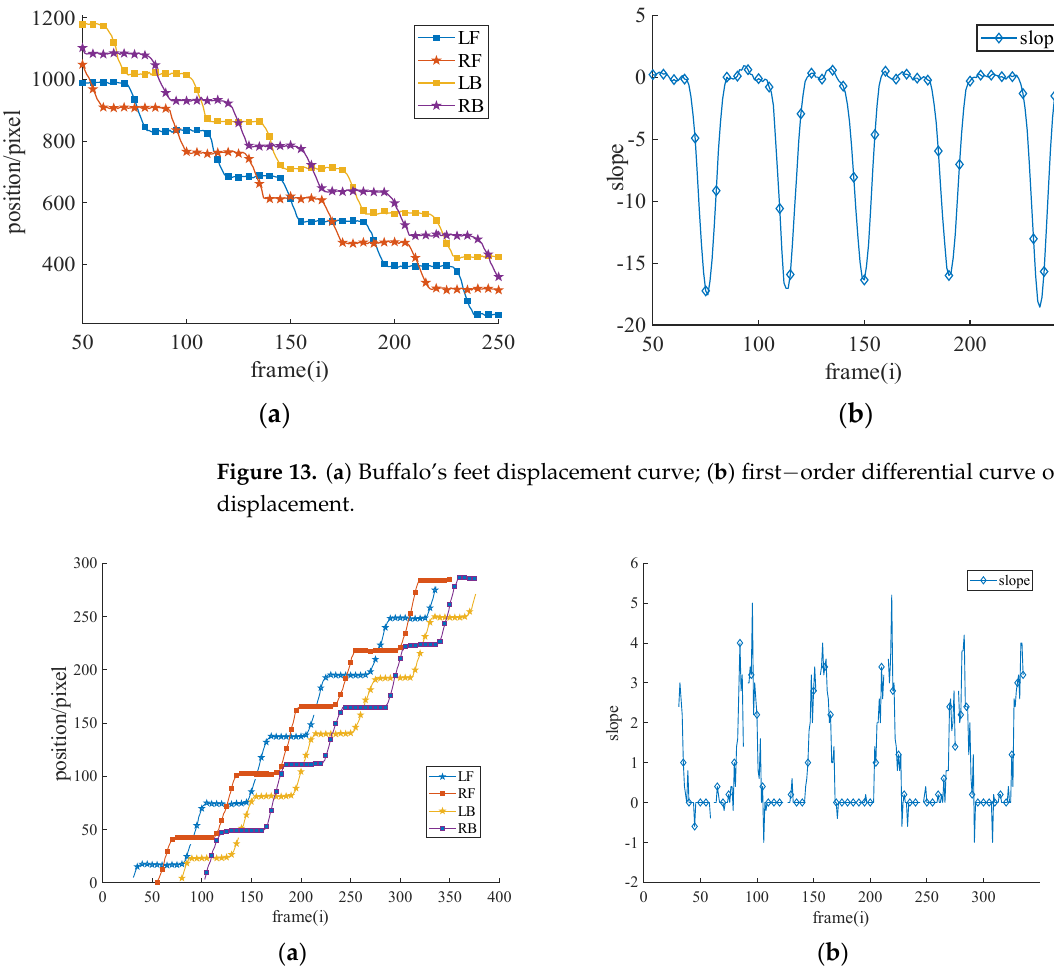
Figure 14. ( a ) Horse’s feet displacement curve; ( b ) first−order differential curve of horse’s feet dis- placement.